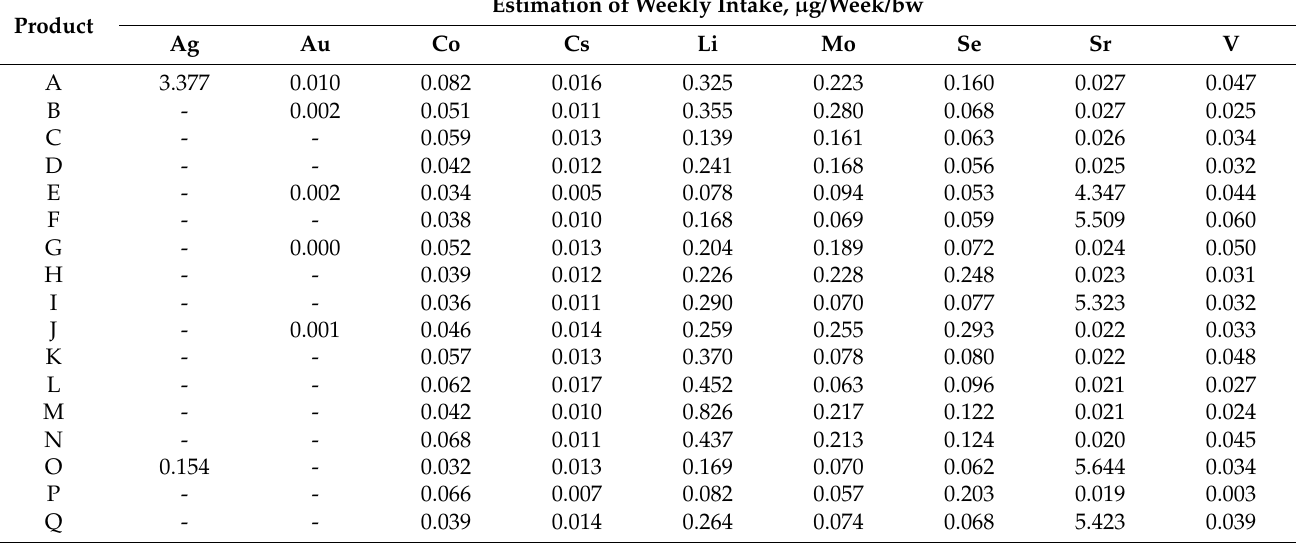
Table 8. The weekly intake per body weight estimation is based on weekly mint tea consumption (six infusions per